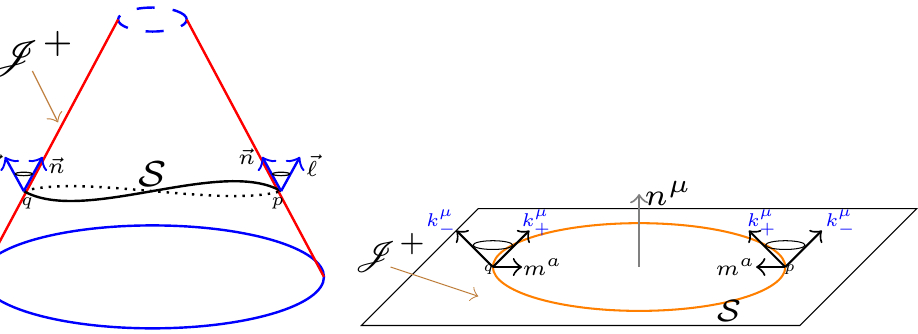
Figure 6. Comparison of J + and null directions orthogonal to a cut S for the case with Λ = 0 ( left ) and the case with Λ > 0 ( right ). On the left the physical spacetime is the region below the cone representing J + and on the right the region below the plane that represents J + . In both cases, two points p and q belonging to the cut are shown, as well as the two null normals to the cut S at those points. On the left, they are provided by n µ itself, and (cid:96) µ , and on the right by k µ ± = ¯ n µ ± m µ , where (cid:126) m is the unit normal to S within J + , such that m µ = m a e µ a . We know that on the left the vanishing of the asymptotic radiant super-momentum Q µ = 0 is equivalent to the vanishing of the news tensor, and thus to the absence of radiation crossing J + . If one modifies the cut passing through, say, p , the picture would be similar, although with a different (cid:126)(cid:96) . All possible such null (cid:126)(cid:96) for all possible cuts through p span the little cone shown above p , and similarly for q . Hence, vanishing of Q µ implies that there is no radiation on any of all those transversal directions spanning the little cone, with the exception, of course, of (cid:126) n , which is not transversal but tangent to J + and actually defines an evolution direction to the future. Notice that Q µ = 0 states that n µ is a multiple principal null direction of the re-scaled Weyl tensor d αβλµ . Inspiration from these properties on the left is used on the right picture to try to isolate a unique component of radiation arriving at the cut S when Λ > 0 (right picture) set Q µ − = 0, assuming that this implies absence of radiation arriving along the directions spanned by the little cones shown above p or q except along k µ − , in analogy with the left-side situation. This would mean that the radiation is arriving basically along the null direction k µ − , which again is a multiple null direction of the re-scaled Weyl tensor, which makes sense. If this interpretation is accepted, the vector m a on the right defines, in analogy with n a on the left, an evolution direction towards the “future” within the spacelike J + . In a way, we can think of the radiation as crossing S towards its exterior (the projection of k µ −